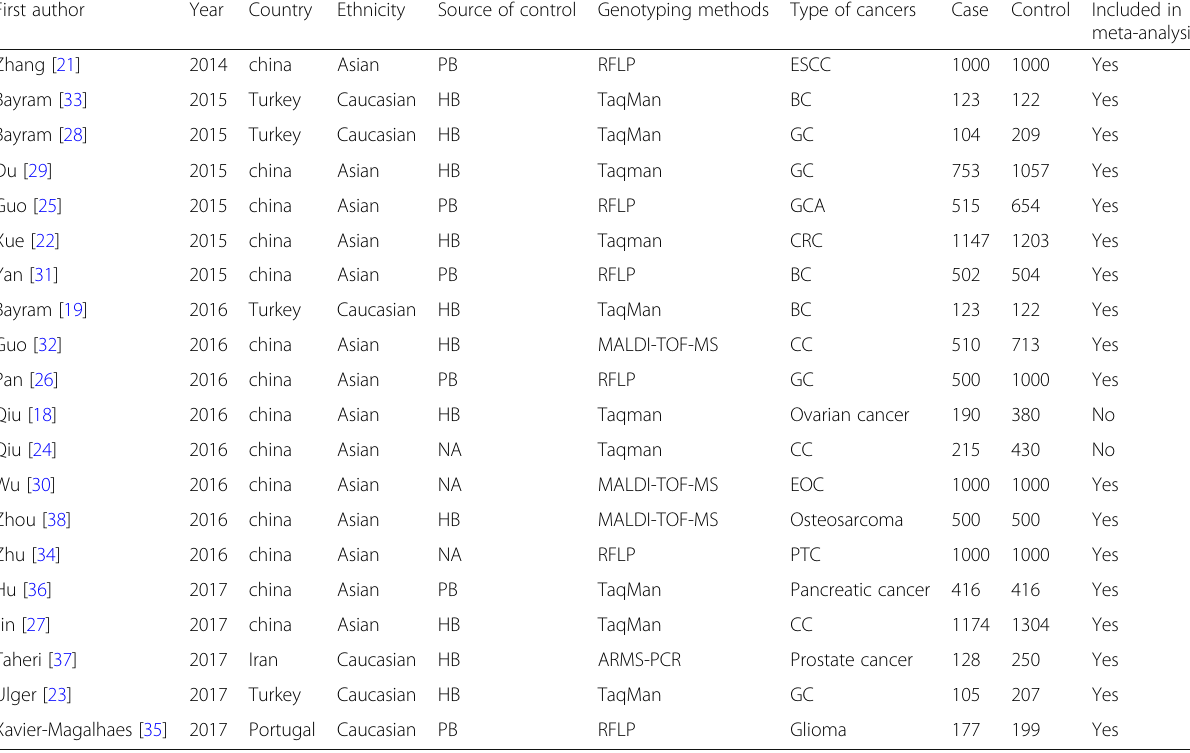
Table 1 Characteristics of studies on HOTAIR polymorphism and cancer